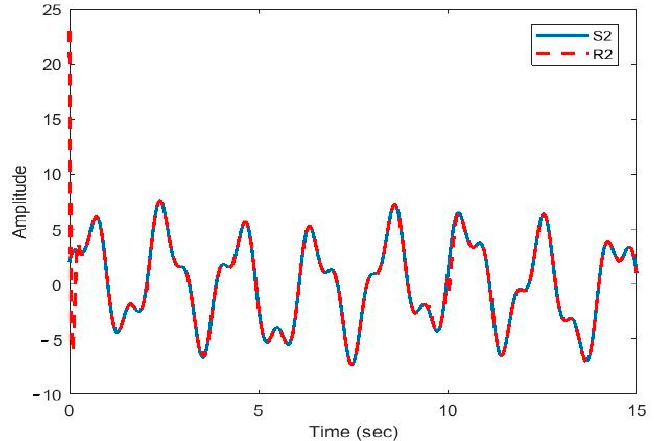
Figure 10. Plot of original signal ( S 2 ) and recovered signal ( R 2 ) obtained using multi-state synchronization and chaotic masking.